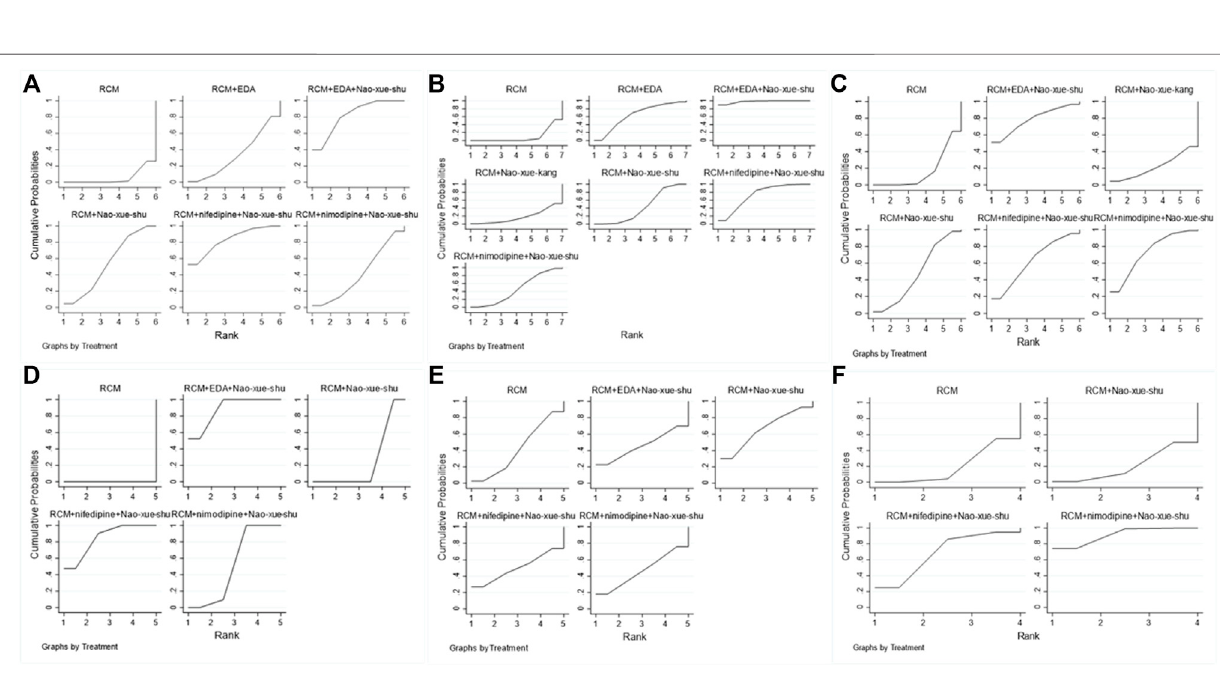
FIGURE 5 | The rank charts. Rank charts based on the (A) effectiveness of different interventions, (B) neurological de fi cit score, (C) hematoma volume after treatment, (D) edema volume after treatment, (E) IL-6 concentration after treatment, and (F) TNF- α concentration after treatment IL, interleukin; TNF, tumor necrosis